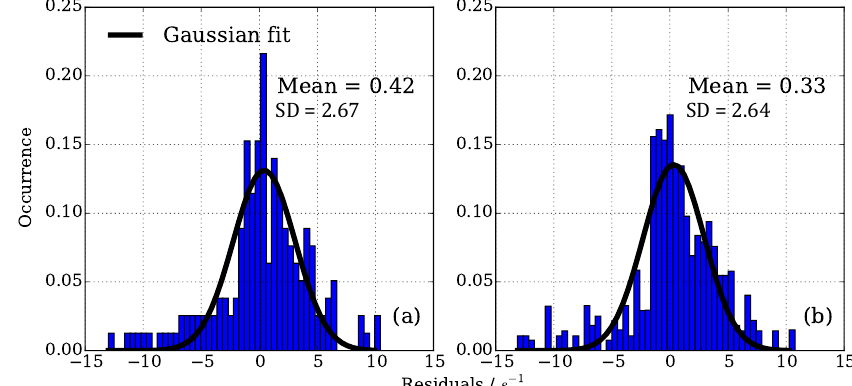
Figure 11. Residuals in CIMS OH reactivity after applying NO correction function. (a) 165 individual points from isoprene, ethene and propane NO correction experiment, (b) 194 individual points from four propane NO correction experiments March 2016–March 2017. Distribution is normalized according to number of points in each experiment.